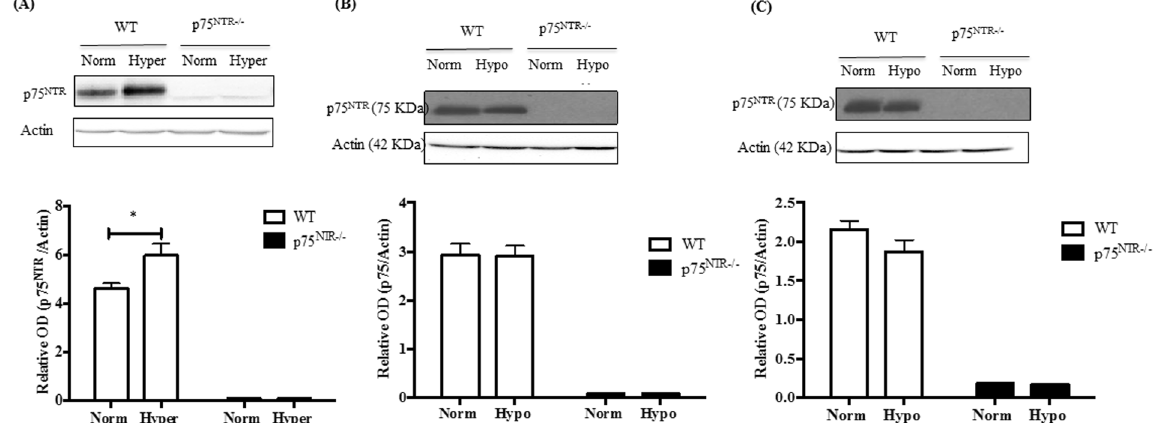
Figure 1. Hyperoxia, but not hypoxia triggered p75 NTR expression in WT-pups in OIR model. ( A ) Exposing WT pups to 70% oxygen from p7-p12 significantly increased p75 NTR expression in WT-pups ( * significant compared to WT-controls using two-way ANOVA, p < 0.05, n = 3–4). ( B ) Western blotting representative and bar graph of p75 NTR receptor expression in WT pups by p14 showing no alteration during hypoxic stage of OIR (n = 4–6). ( C ) Western blotting representative and bar graph of p75 NTR receptor expression in WT pups by p17 showing a trend for decreased p75 NTR expression that was not statistically significant (n = 4).